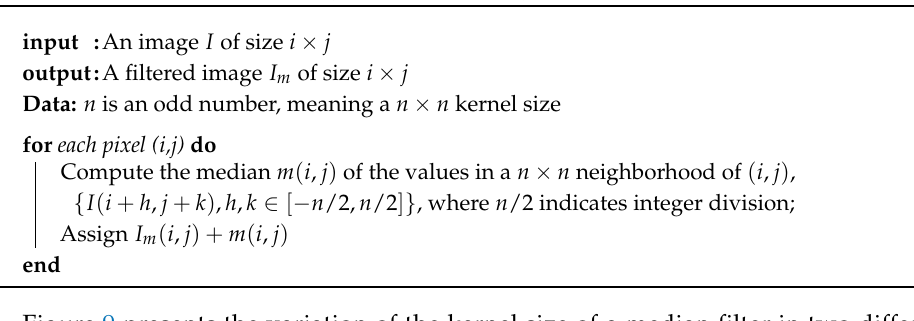
Algorithm 1: Median Filter Algorithm according to Trucco and Verri [27].